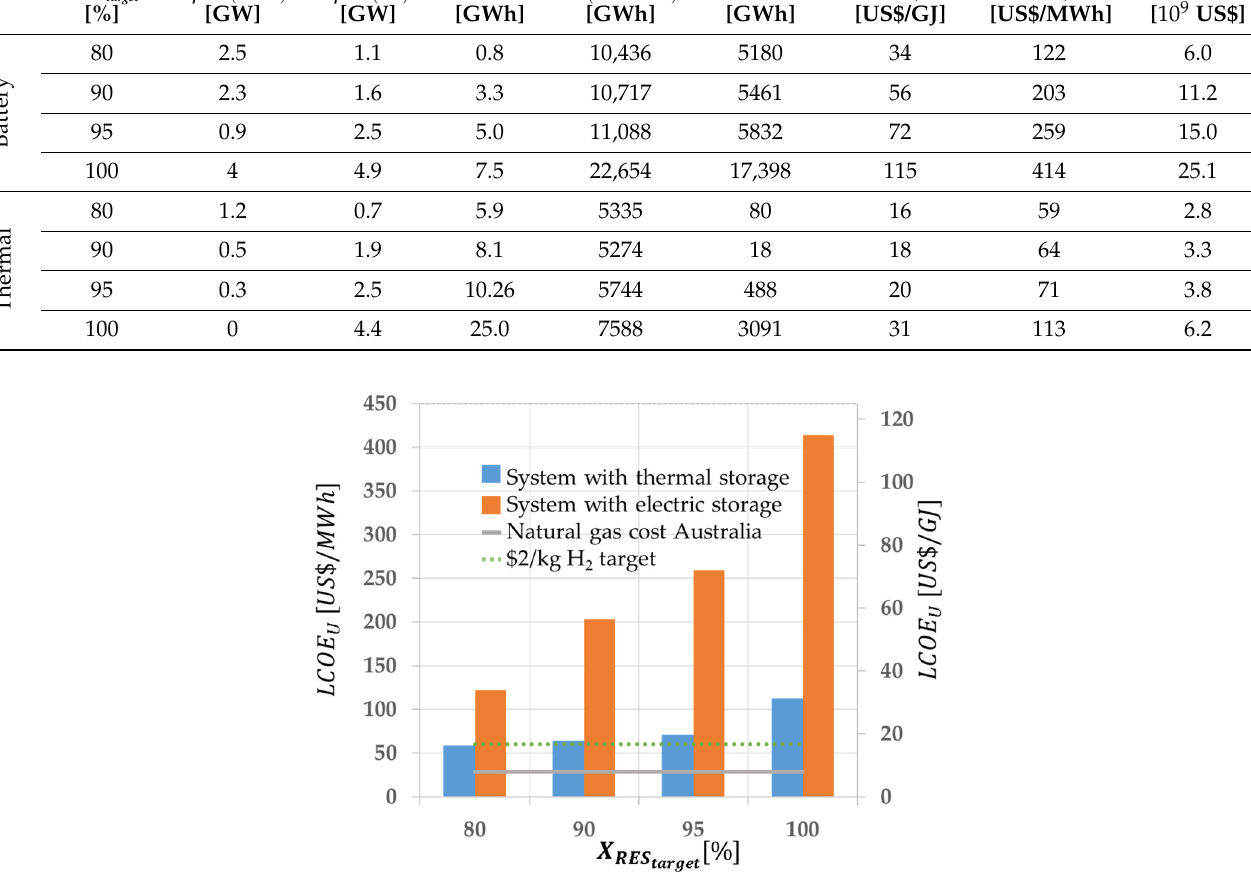
(cid:16) (cid:17) ) de- X RES defined (cid:3295)(cid:3276)(cid:3293)(cid:3282)(cid:3280)(cid:3295) target